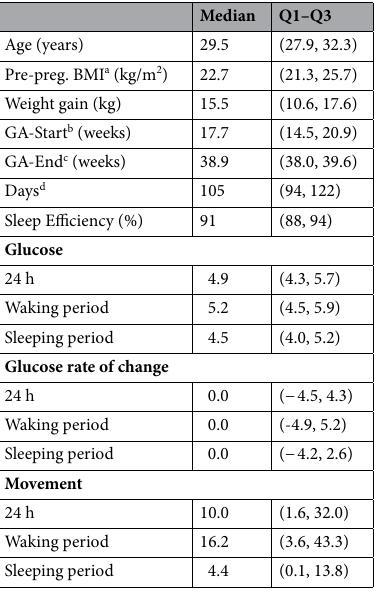
Table 1. Study cohort characteristics and values for blood glucose (mmol/l), glucose rate of change (%) and movement (mg) over 24 h and for waking and sleeping periods. Presented as median with 1st and 3rd quartiles (Q1–Q3). a Pre-pregnancy body mass index. Gestational age at the start b and end c of the aligned movement and glucose rate of change data. d Days of aligned movement and glucose rate of change